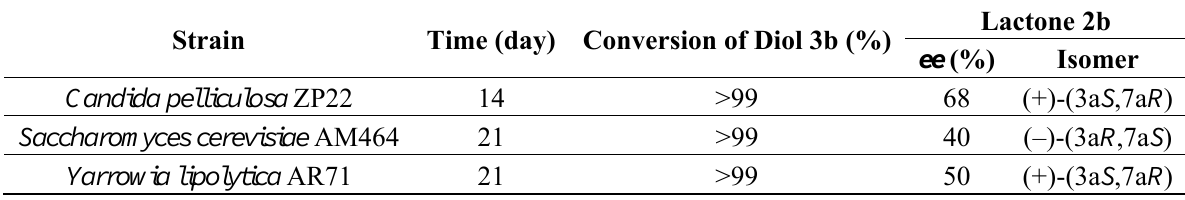
Table 2. The conversion (according to chiral gas chromatography, CGC) of diol 3b in the course of screening-scale oxidation conducted in